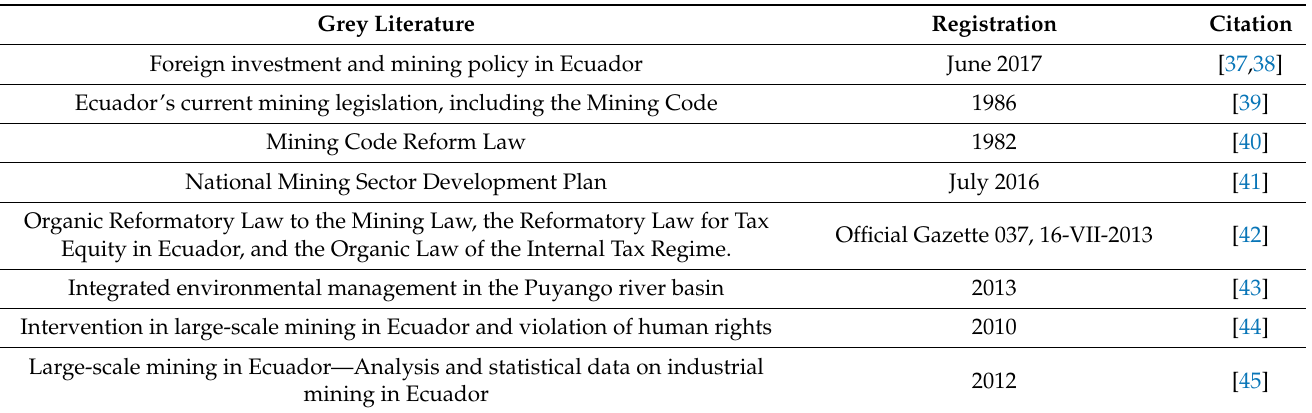
Table 3. Selected and reviewed grey